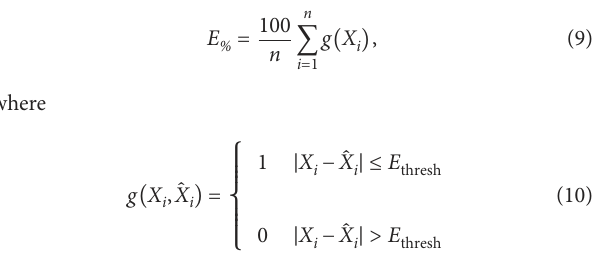
Frontiers in Robotics and AI